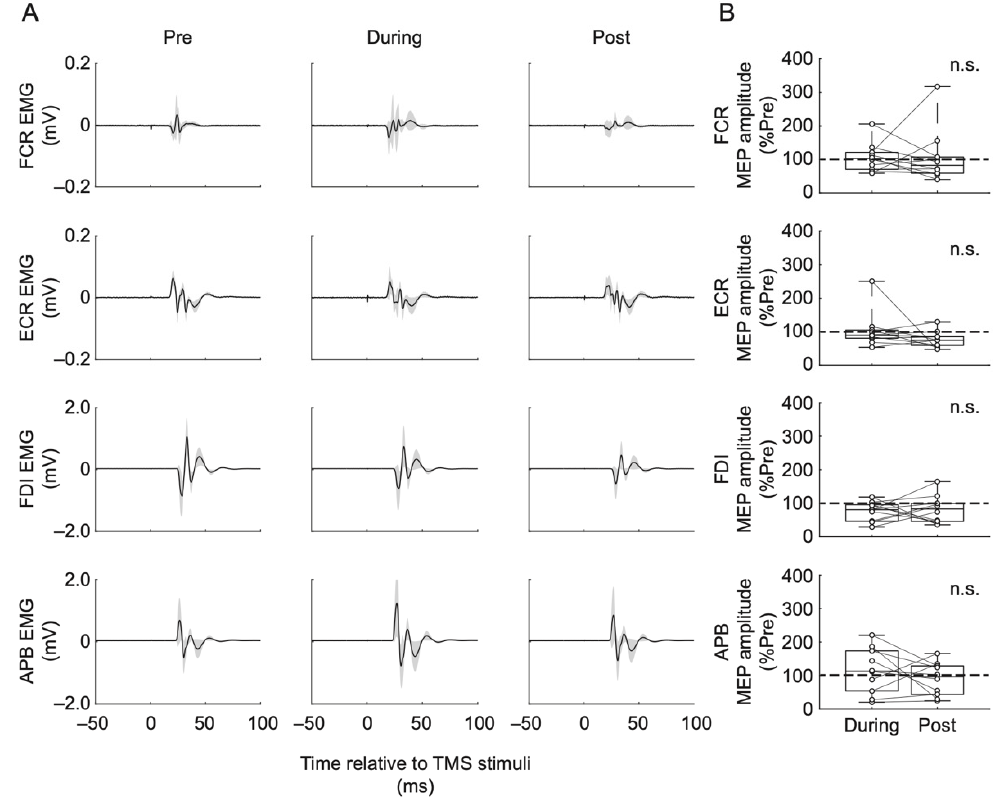
Figure 2. ( A ) Averaged motor evoked potentials (MEPs) for one representative participant at before (Pre), during continuous cervical tSCS (During), and after (Post) assessment points. Shadows represent standard deviation. ( B ) Box plots show MEP amplitude group data in each assessment point. MEP amplitudes were normalized with respect to the MEP amplitude during the Pre assessment (% of Pre) for each participant. Data are shown for the flexor carpi radialis (FCR), extensor carpi radialis (ECR), first dorsal interosseous (FDI), and abductor pollicis brevis (APB) muscles. The horizontal lines in the box plots indicate median values. The ends of the boxes represent the 25th and 75th percentiles. The whiskers on the box plots illustrate the minimum and maximum values. Legend: n.s., non-significant.